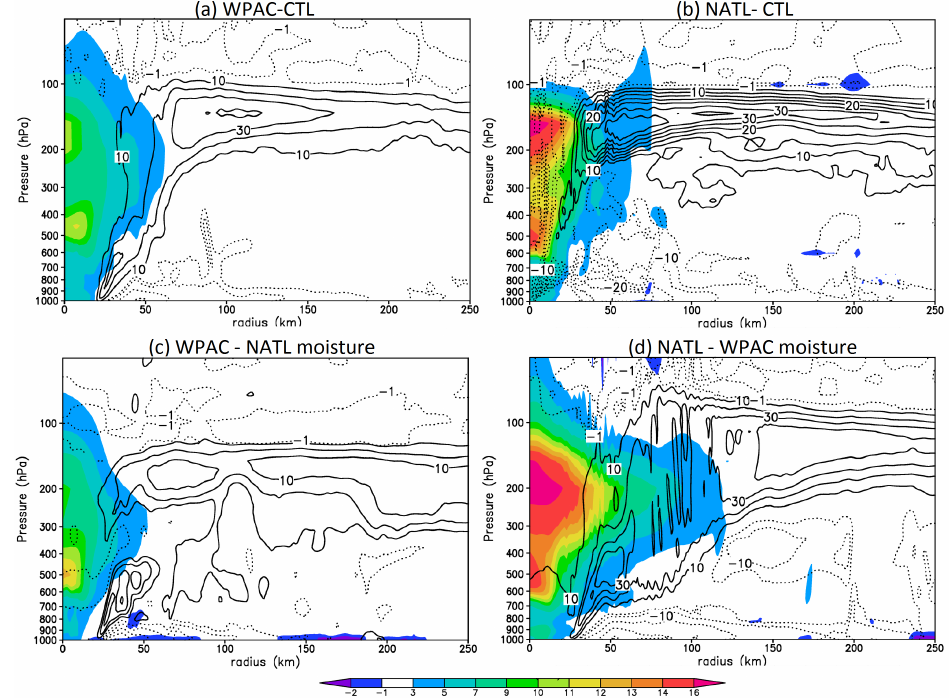
Figure 6. Radius-height cross-sections through the center of the storm of the temperature anomaly (K, shaded) for ( a ) WPAC-CTL, ( b ) NATL-CTL, ( c ) WPAC-RH switched, and ( d ) NATL-RH switched experiments valid at t = 120 h. Solid (dotted) line contours are positive (negative) values of radial (in-plane) wind with a contour interval of 5 m s − 1 , with ± 1 contours also